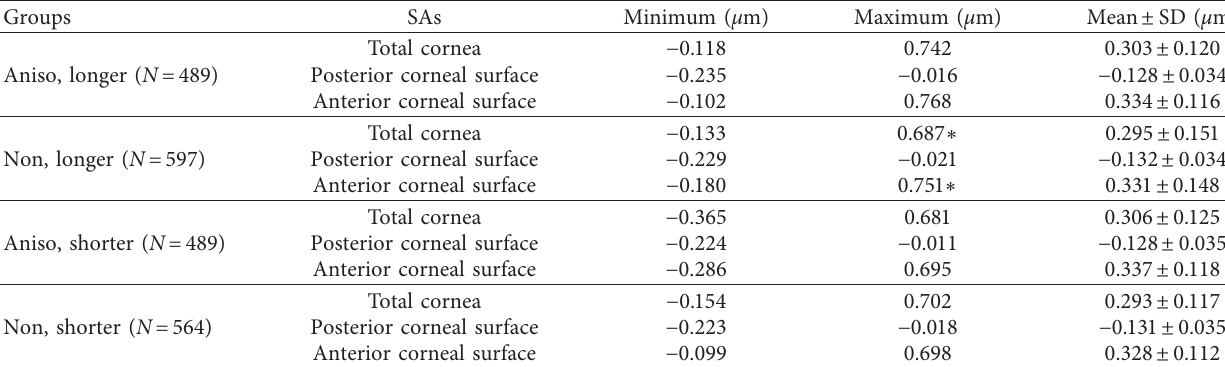
Table 4: Distributions of total, anterior, and posterior corneal SAs in different